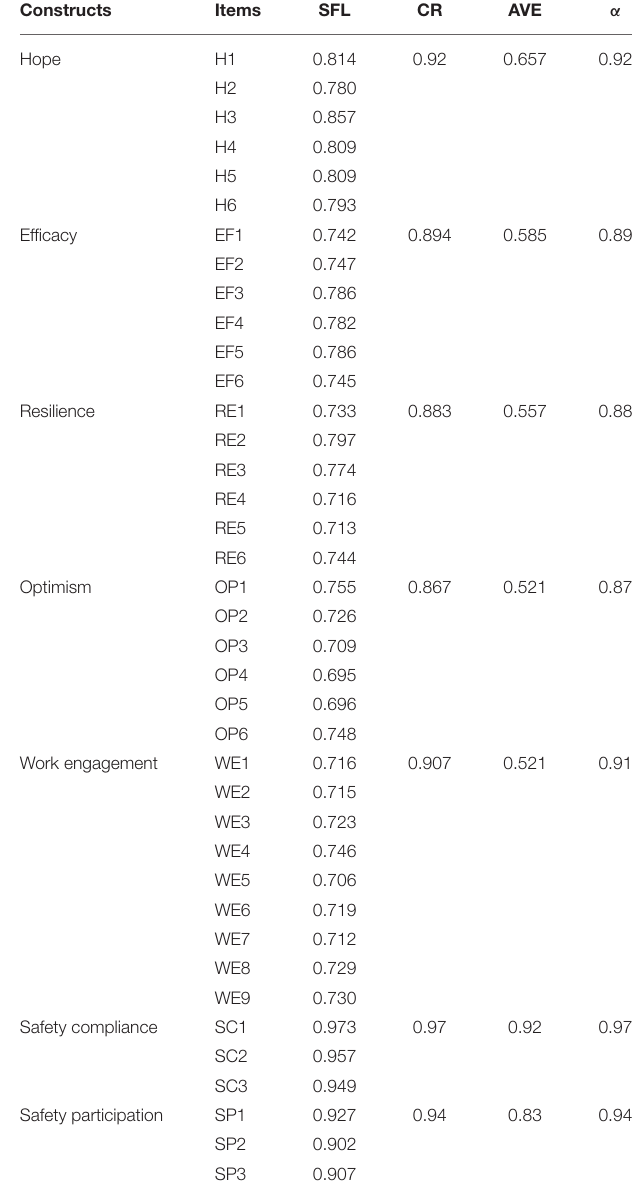
Table 4 represents the overall one-factor model fit statistics against the confirmatory factor analysis (CFA), which shows that our results are acceptable and a good fit was achieved for the measurement model of PsyCap and work engagement. To summarize the scales’ reliability, convergent validity, and discriminant validity, our study findings support that the internal factor structure of all scales being tested is well-validated and reliable by meeting the convergent validity as well as discriminant criterion with associated variables (112). These findings